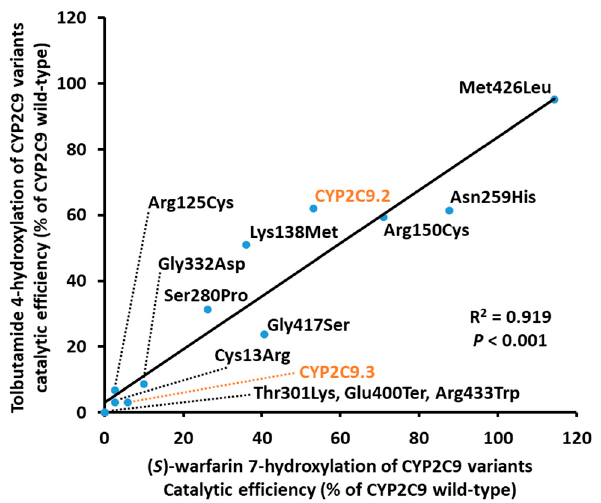
Figure 3. Correlation between the catalytic efficiency ratios for ( S )-warfarin 7-hydroxylation and tolbutamide 4-hydroxylation among CYP2C9 variants. ( S )-Warfarin 7-hydroxylation ratios are plotted on the horizontal axis, and tolbutamide 4-hydroxylation ratios are plotted on the vertical axis. Ter represents amino acid termination. Table 3. Kinetic parameters of ( S )-warfarin 7-hydroxylation by microsomes from 293FT cells expressing wild-type and variant CYP2C9 proteins.